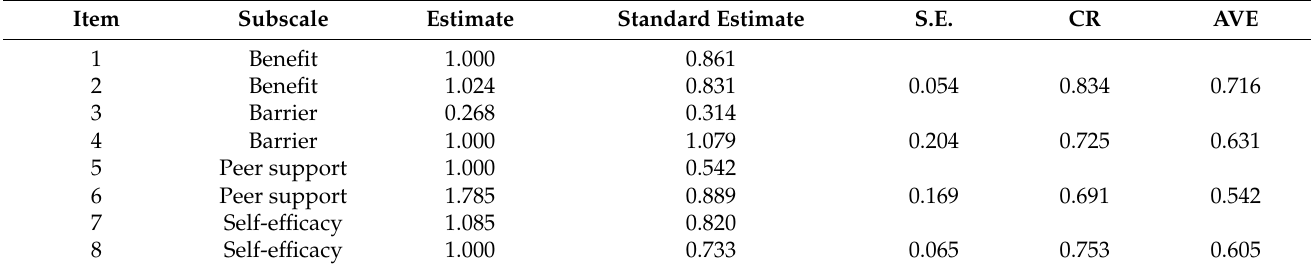
Table 6. Convergent validity analysis of PrEP adherence questionnaire.